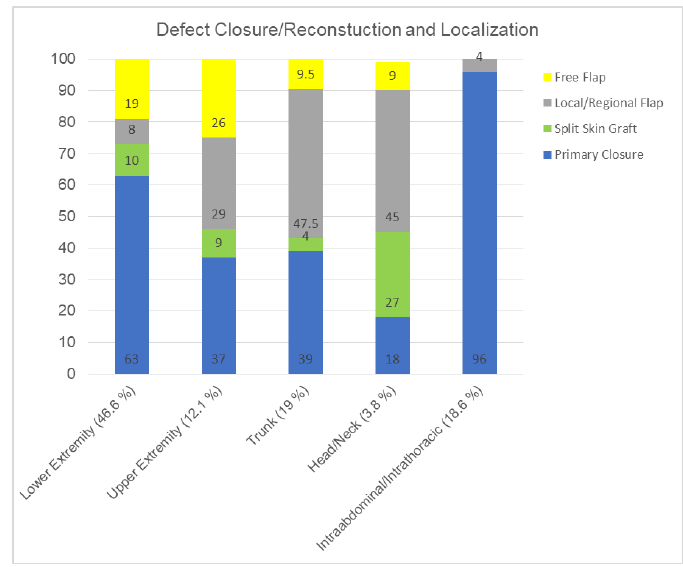
Figure 2. Overview of the percentages of defect/tissue/function reconstruction types depending on the localization.